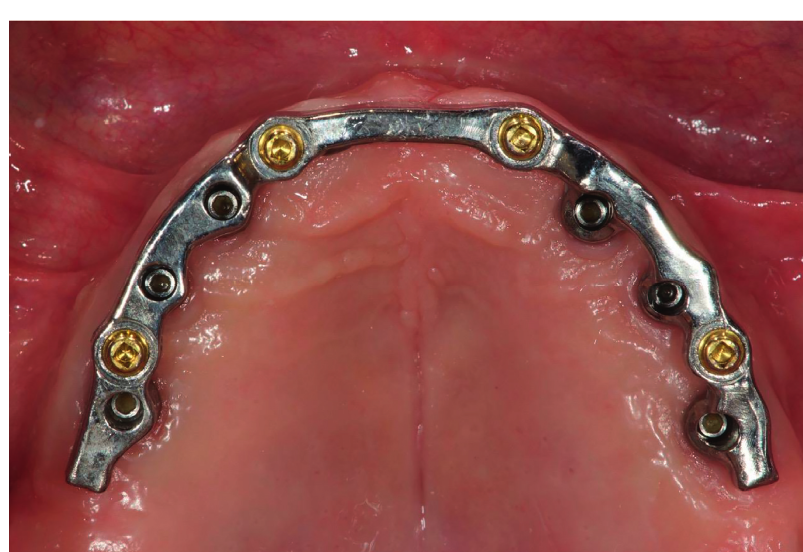
Figure 2: Intraoral clinical image of the CAD/CAM titanium bar with low-profile attachments (OT Equator attachments, Rhein 83, Bologna,